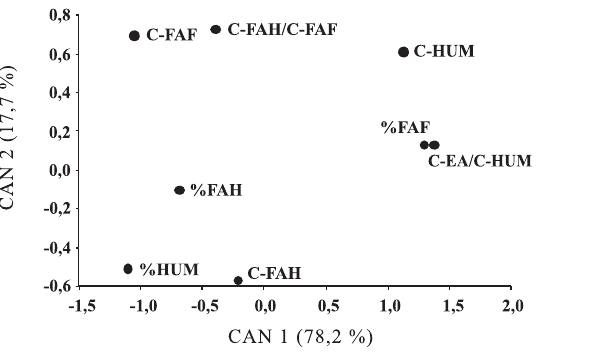
Figura 2. Dispersão dos coeficientes canônicos (padronizados) das variáveis